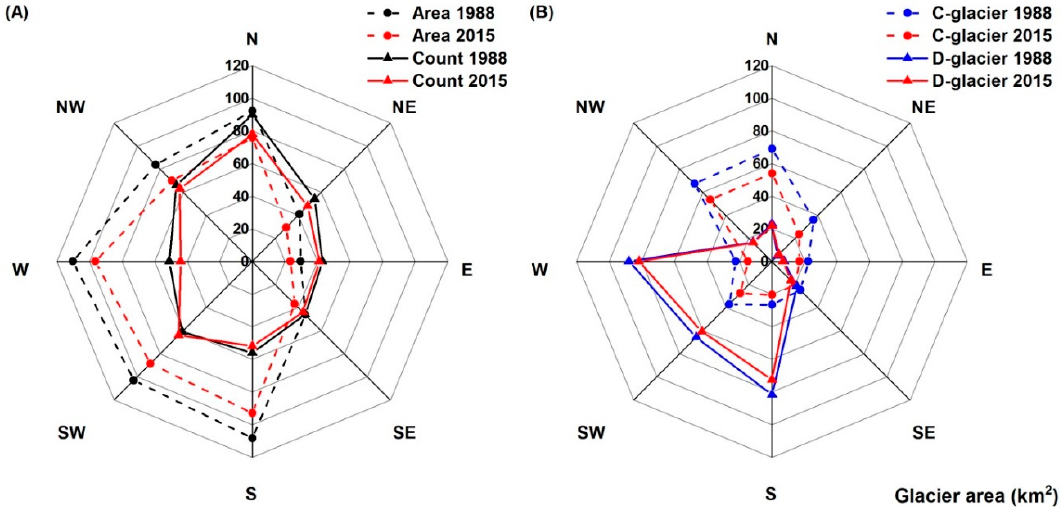
Figure 7. Aspect distributions of glaciers in GRB: ( A ) areas and counts for all glaciers; ( B ) areas for C-glaciers and D-glaciers in 1988 and 2015.